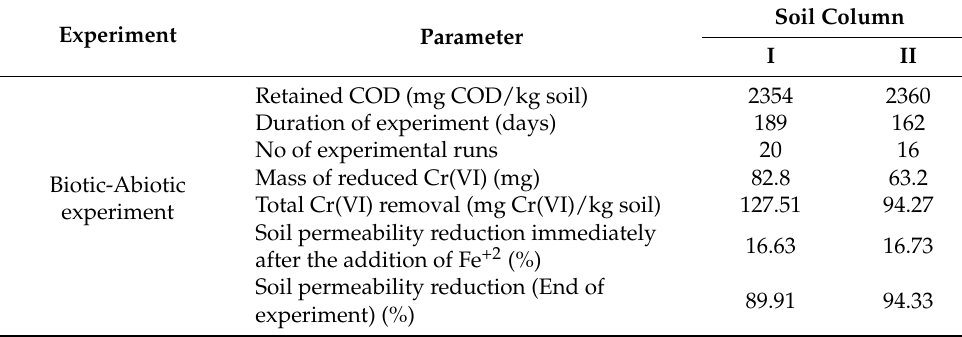
Table 6. Experimental results from the Biotic-Abiotic experiment.